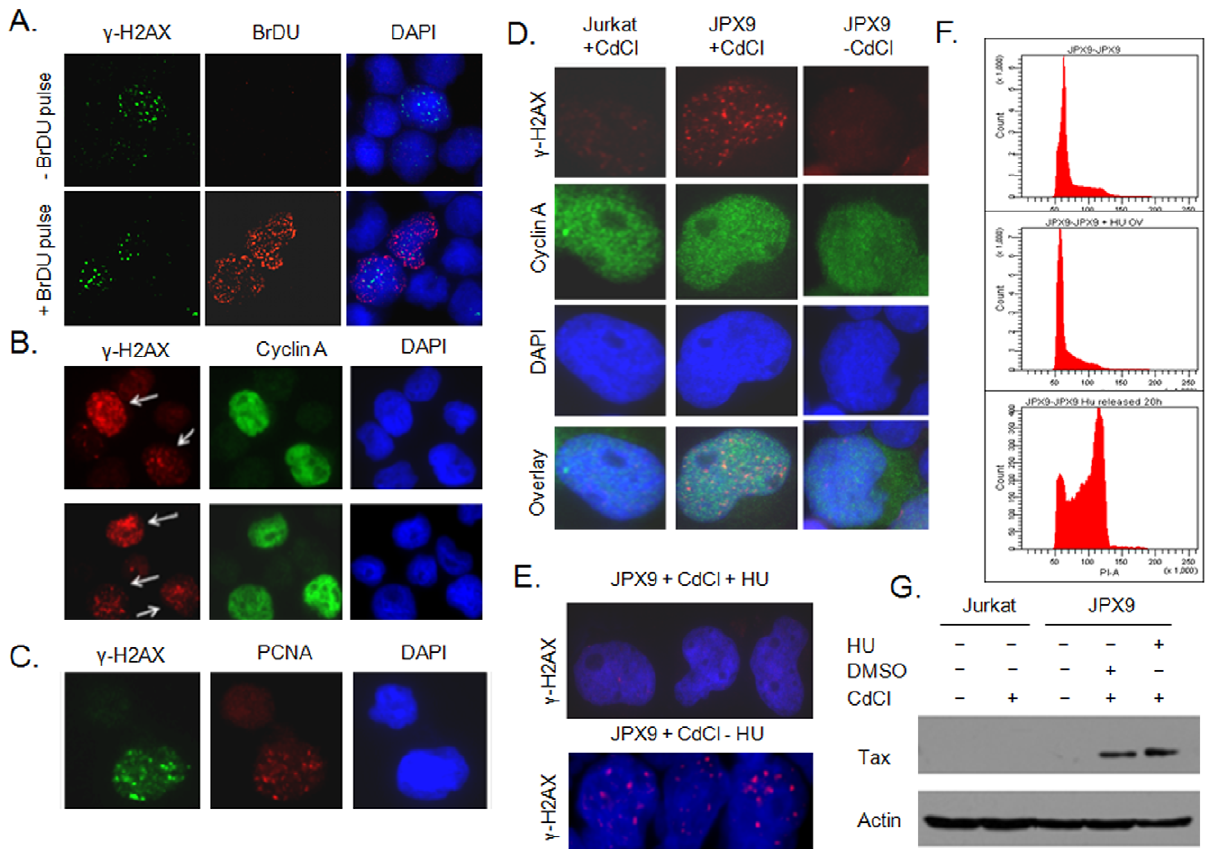
Figure 2. Tax-associated DDSB occur in S phase during DNA replication. A) HTLV-I-transformed MT-2 cells were pulse-labeled with BrDU to identify cells in S phase of the cell cycle. Immunofluorescence experiments indicated that c -H2AX foci are detected in BrDU positive cells only. Cells were counter stained with DAPI. B) HTLV-I-transformed MT-2 cells were dual stained with Cyclin A, a marker of S phase, and c -H2AX, a marker of DDSB foci. Cells were counter-stained with DAPI. C) HTLV-I-transformed MT-2 cells were dual stained with PCNA, which appear as a punctuated pattern in S phase, and c -H2AX, to reveal DDSB foci. Cells were counter-stained with DAPI. D) Accumulation of DDSB foci in S phase was confirmed in Tax-only expressing cells using Tax-inducible JPX9 cells and Jurkat control, both treated with CdCl and dual-stained with Cyclin A and c -H2AX antibodies. E) JPX9 cells were synchronized in G0/G1 by exposure to hydroxyurea (HU) overnight. G0/G1 JPX9 cells and non-synchronized JPX9 cells were exposed to CdCl to induce Tax expression and analyzed for presence of c -H2AX DDSB foci. F) Efficacy of HU treatment was demonstrated by cell cycle analyses by FACS after PI staining. From top to bottom, untreated cells, HU G1-arrested cells, HU G1-arrested cells released by washing out HU and culturing 20 hours. G) Western blot analyses confirmed that HU treatment did not affect Tax expression.